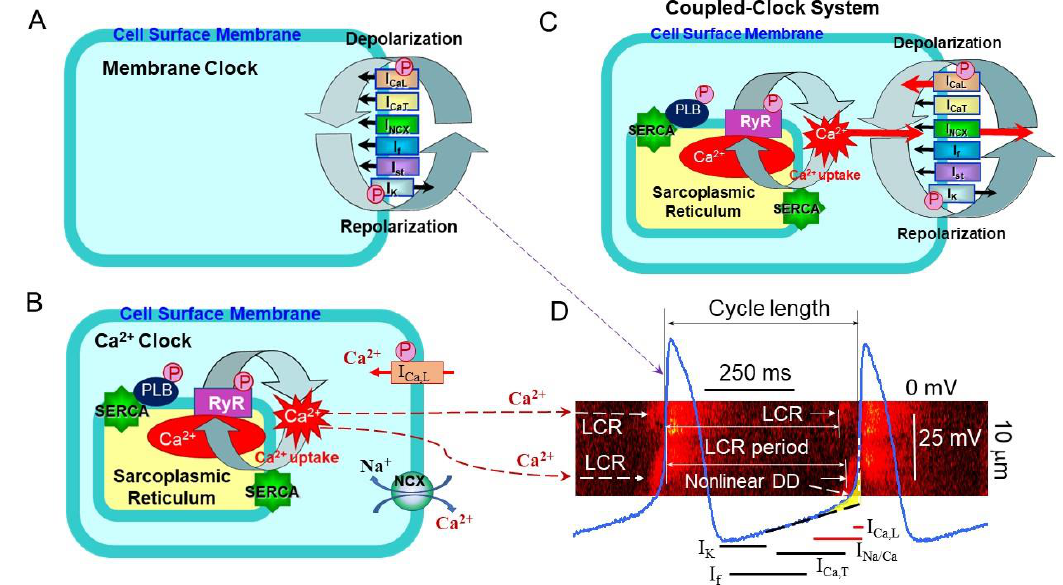
Figure 1. A schematic illustration of the coupled-clock pacemaker system. ( A ) Schematic presentation of ion channels “membrane clock” (including the hyperpolarization activated “funny” current I f , L-type and T-type Ca 2+ currents (I Ca,L , I Ca,T ), delayed rectifier potassium current (I K ), Na + /Ca 2+ exchange current (I NCX ), Na + /K + exchange current (I NaK ), sustained current I st , etc.) and ( B ) “Ca 2+ clock” in cardiac pacemaker cells. Note that both L-type Ca 2+ channels and Na + -Ca 2+ exchanger are part of the “membrane clock” and “Ca 2+ clock”. Panel ( C ) illustrates the “coupled-clock” system with complex interactions between the “membrane clock” and “Ca 2+ clock” (see text for details). ( D ) Schematic illustration of spontaneous SANC action potentials, Ca 2+ transients, LCRs, and several major ion currents involved in generation of the diastolic depolarization (DD). LCR-induced increase in local [Ca 2+ ] beneath sarcolemma activates an inward NCX current creating exponential increase in the DD rate (nonlinear DD). The LCR period represents the essence of the “coupled-clock” system, which comprises complex interactions between cell membrane electrogenic molecules and intracellular SR Ca 2+ cycling (see text for details).